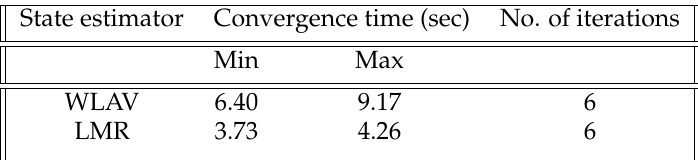
Table 9. IEEE 118 Bus - Computation efficiency of the state